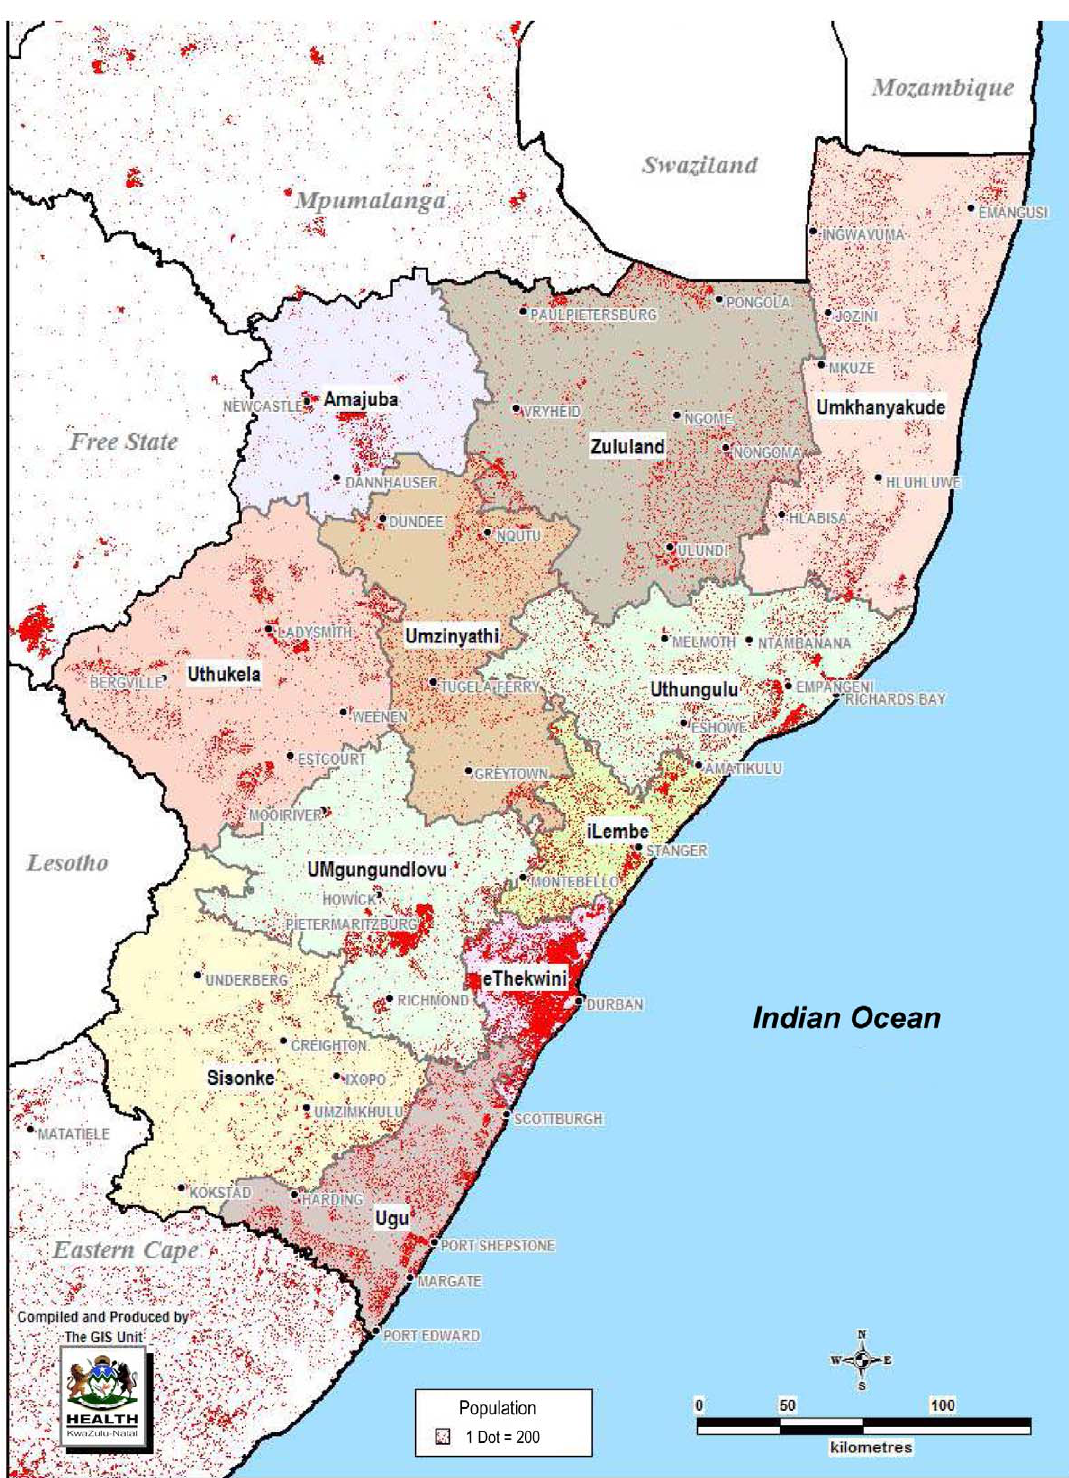
Figure 1. Health districts of KwaZulu-Natal province and population density.